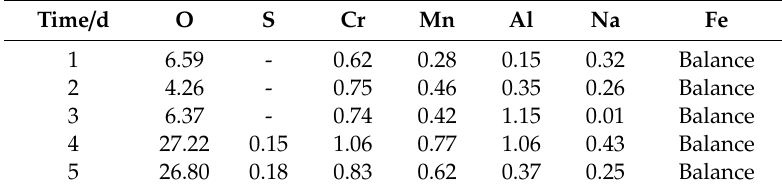
Table2. EDSmappingresultsof12Cr1MoVsteelcorrodedfordi ff erenttimesintheTCSAsolution(wt%). Table 2. EDS mapping results of 12Cr1MoV steel corroded for different times in the TCSA solution (wt%).